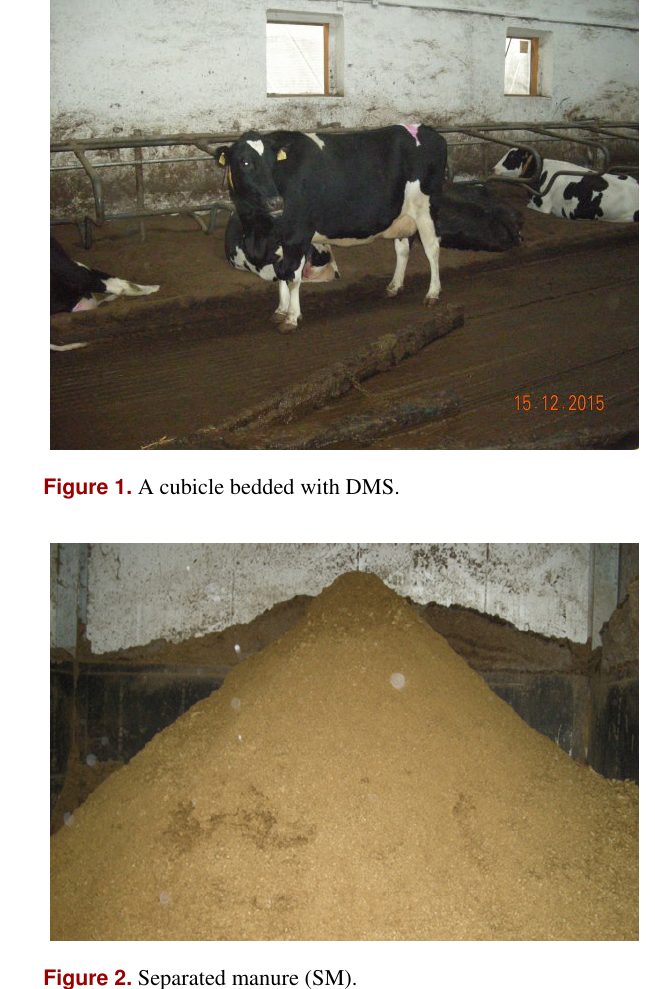
Figure 2. Separated manure